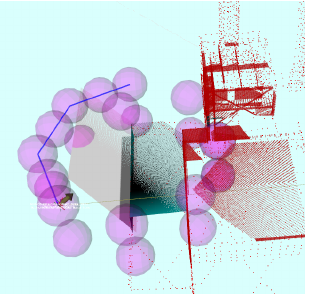
Figure 7. The circular collision box in purple created around the UAV locations to check the validity of the viewpoints. The path of the UAV is shown in blue and the scans are presented in dark red.